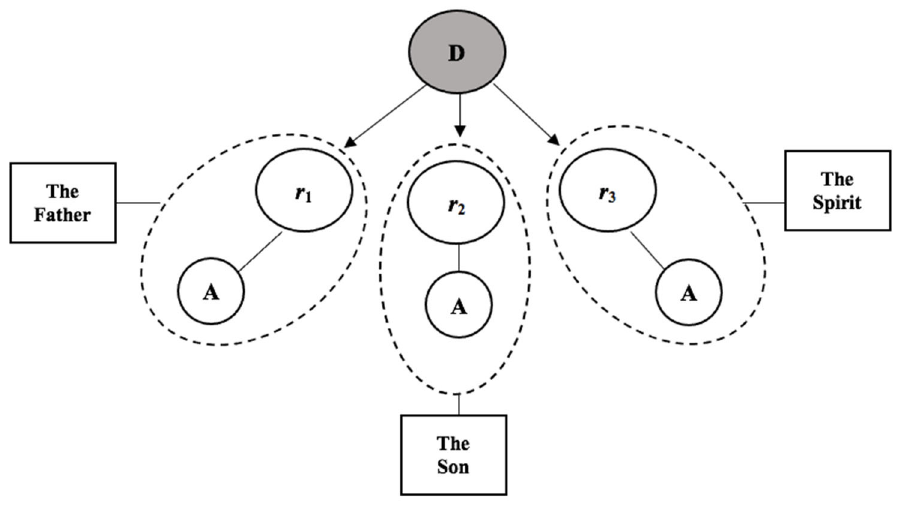
Figure 7. Divinity ‐ Aspects